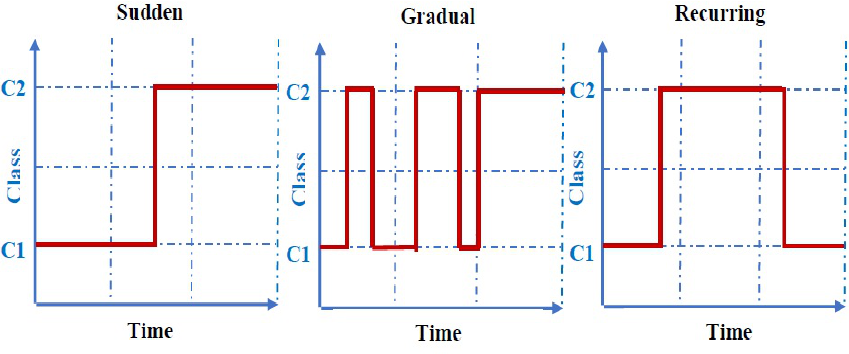
Figure 2. Concept Drift